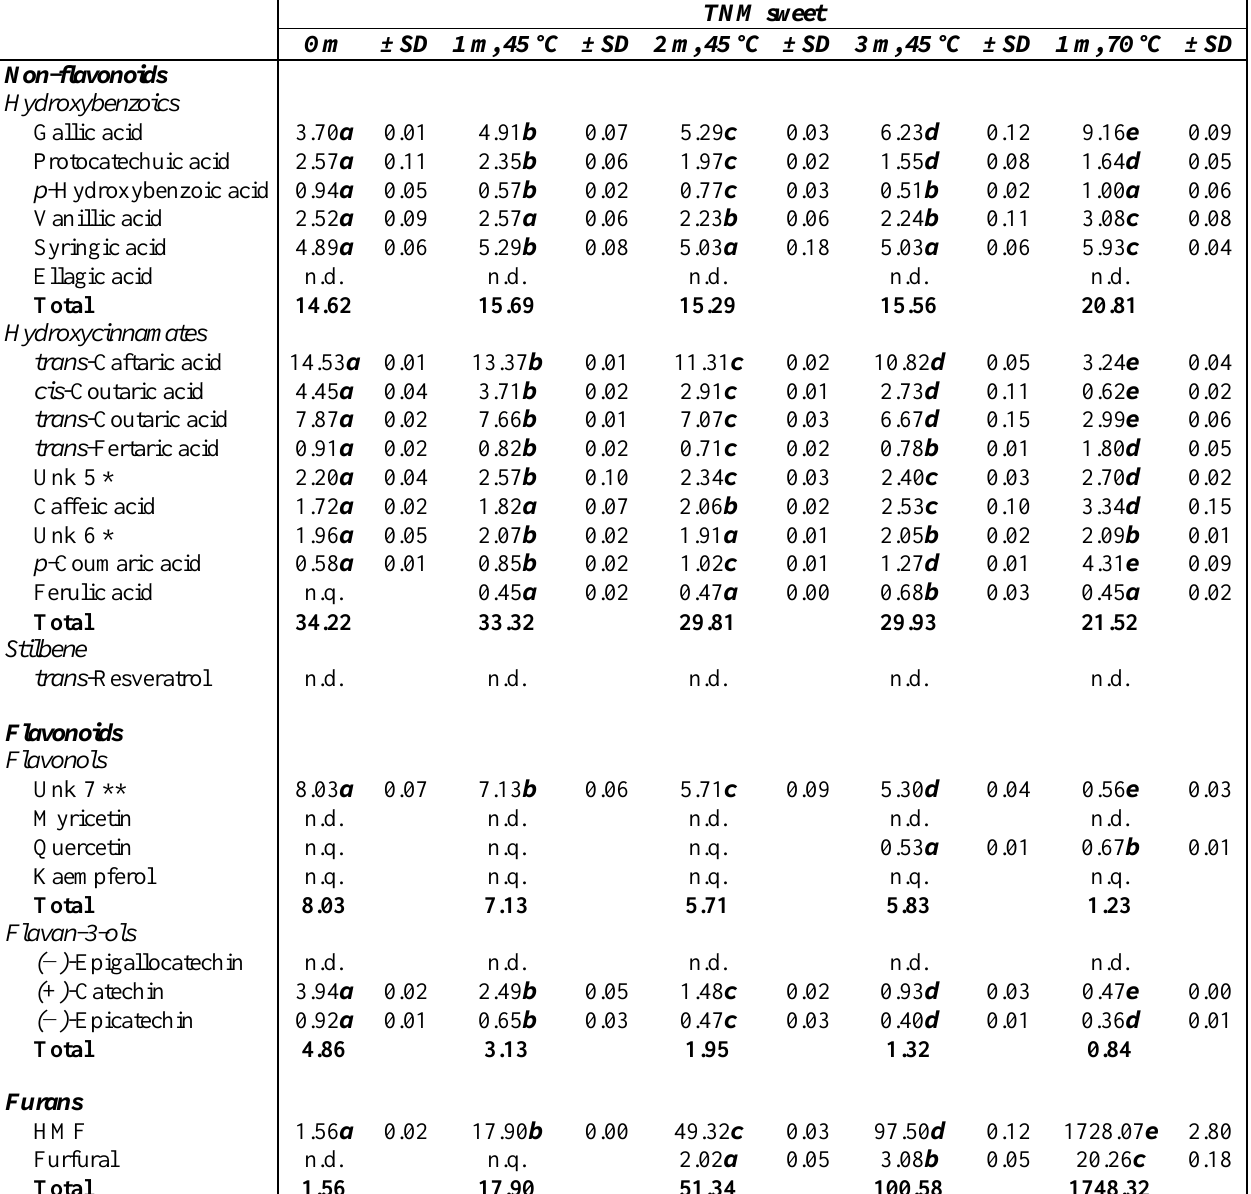
Table 2. Individual polyphenols and furans (mg/L) in TNM sweet wine during heating at 45 °C (3 months) and 70 °C (1